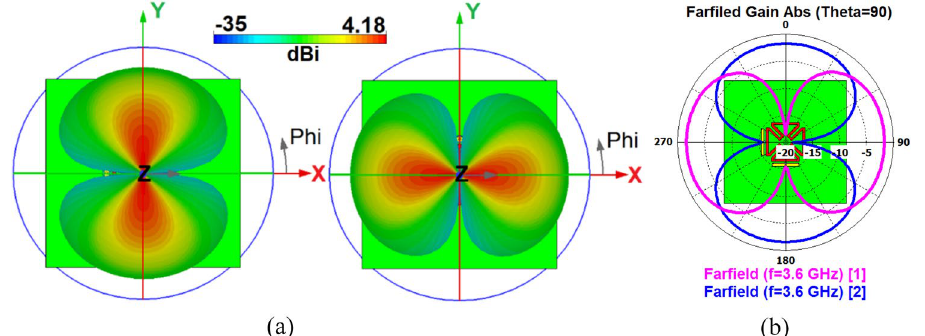
Figure 3. ( a ) 3D and ( b ) 2D